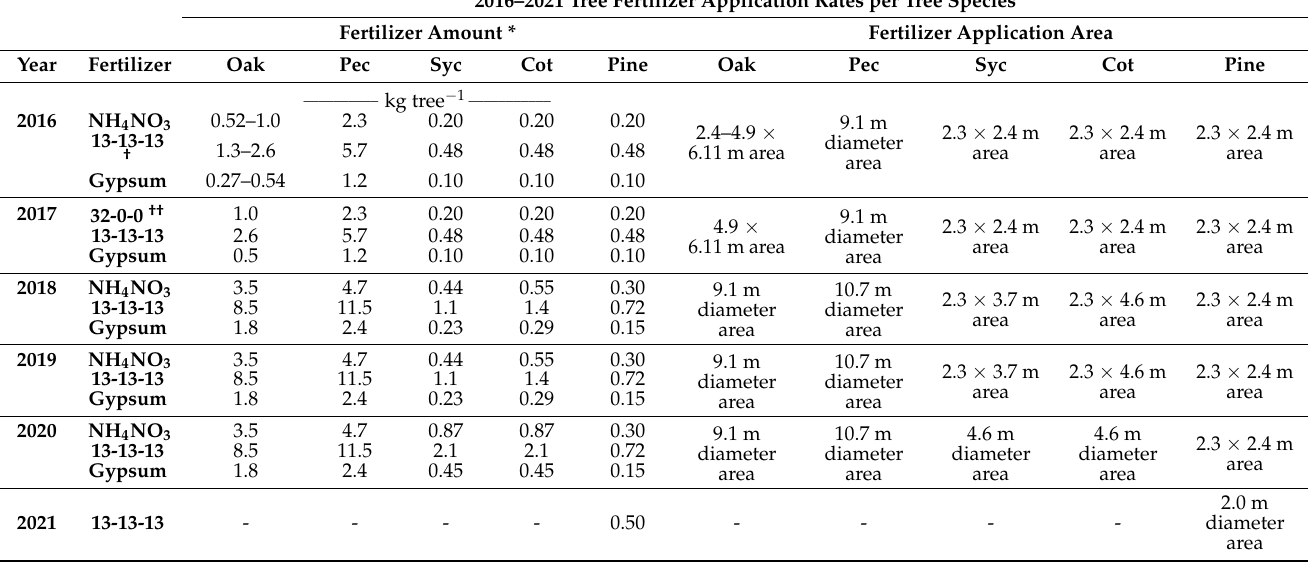
Table 1. Summary of the fertilizer types (i.e., NH 4 NO 3 , 13-13-13, gypsum (CaSO 4 )), amounts, and application areas of the fertilizers used to fertilize the trees (i.e., Northern red oak ( Quercus rubra L.), pecan ( Carya illinoinensis Wangenh. K. Koch), American sycamore ( Plantanus occidentalis L.), cottonwood ( Populus deltoides W. Bartram ex Marshall), and pitch/loblolly pine ( Pinus rigida x Pinus taeda )) of an agroforestry site in Fayetteville, AR between 2016 to